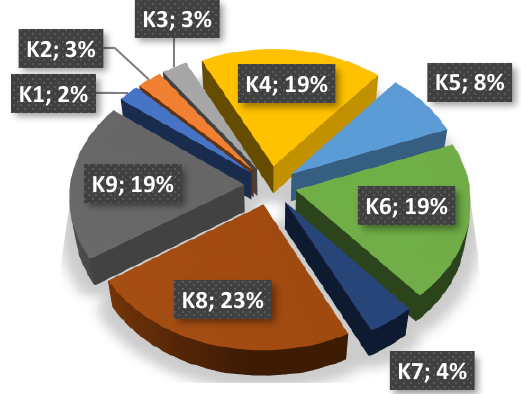
Figure 8. Weighted criteria expressed as percentages, according to Expert 5.